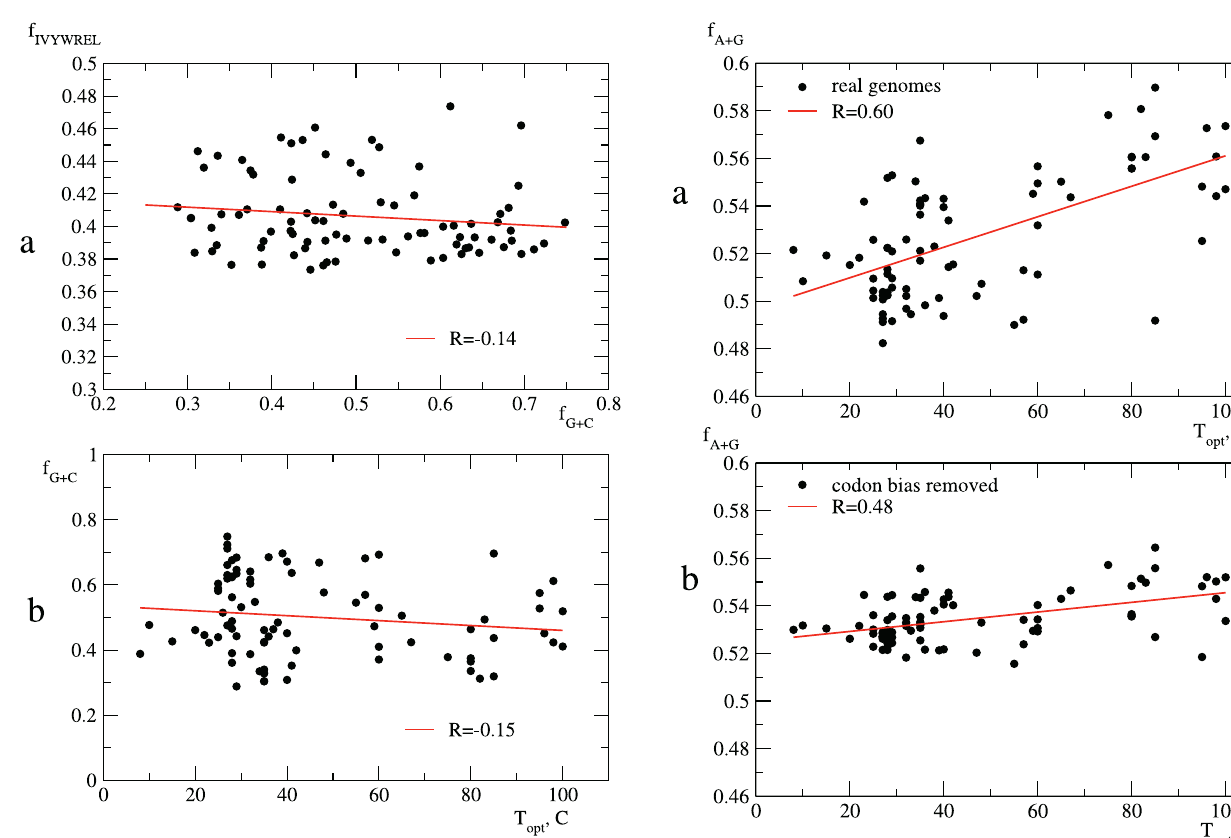
Figure 7. Effect of Codon Bias on the Increase of Purine Load with OGT (A) The fraction of A þ G in the coding DNA of the 83 complete genomes is highly correlated with the OGT, R ¼ 0.60. (B) When protein sequences of the 83 organisms are reverse-translated into DNA without codon bias, the fraction of A þ G remains correlated with OGT, R ¼ 0.48.